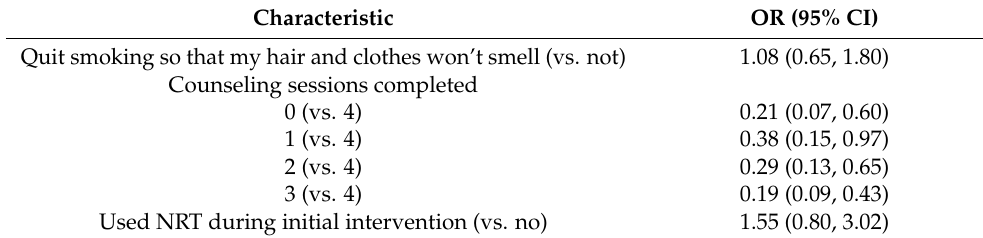
Table 3. Cont. Characteristic OR (95% CI) Quit smoking so that my hair and clothes won’t smell (vs. not) 1.08 (0.65, 1.80) Counseling sessions completed 0 (vs. 4) 0.21 (0.07, 0.60) 1 (vs. 4) 0.38 (0.15, 0.97) 2 (vs. 4) 0.29 (0.13, 0.65) 3 (vs. 4) 0.19 (0.09, 0.43) Used NRT during initial intervention (vs. no) 1.55 (0.80, 3.02) OR: odds ratio; CI: confidence interval. Due to small sample sizes across each race, we were unable to differ- entiate between non-White categories. Therefore, the “Other races“ category includes Black, Asian,